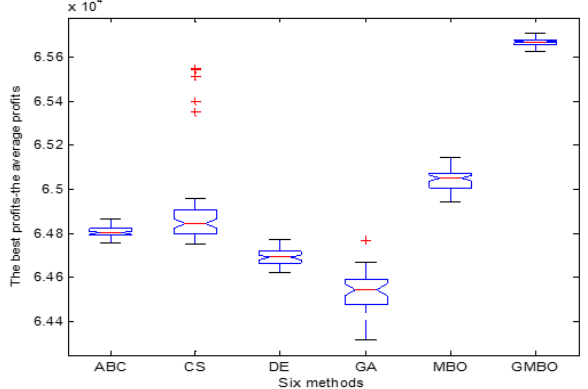
Figure 15. Boxplot of the best values on KP9 in 50 runs.